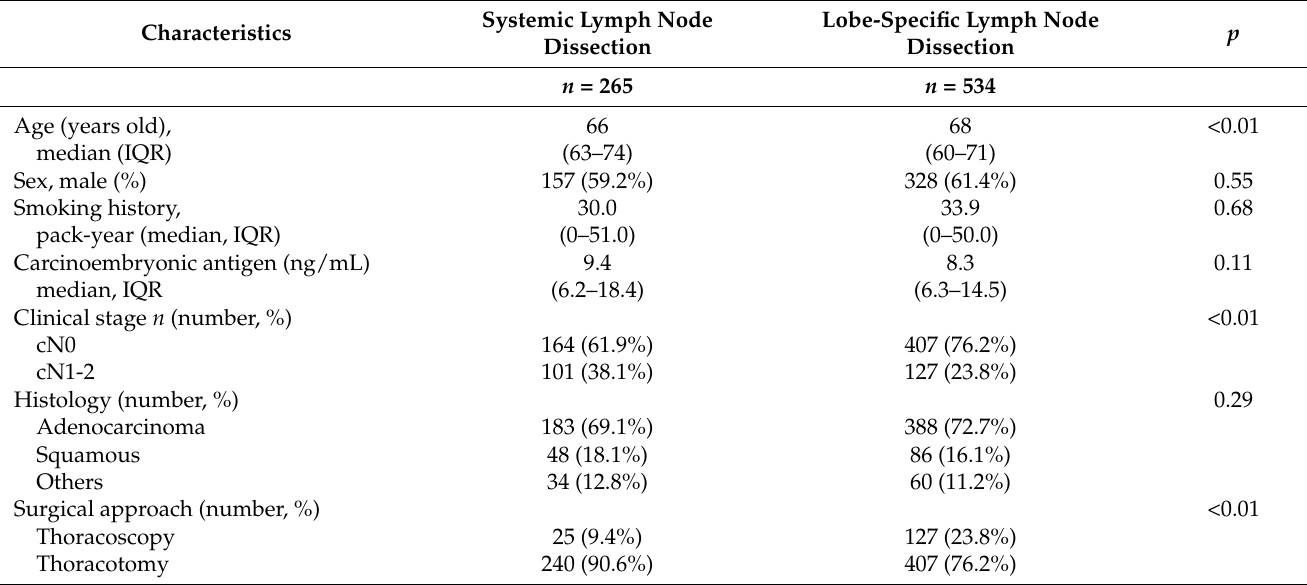
Table 1. Characteristics of the tissues used for genomic